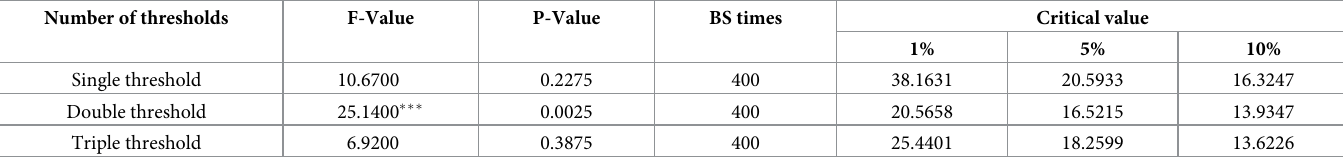
Table 5. Results of the self-sampling test on threshold effect of core explanatory variables lagging behind one period.